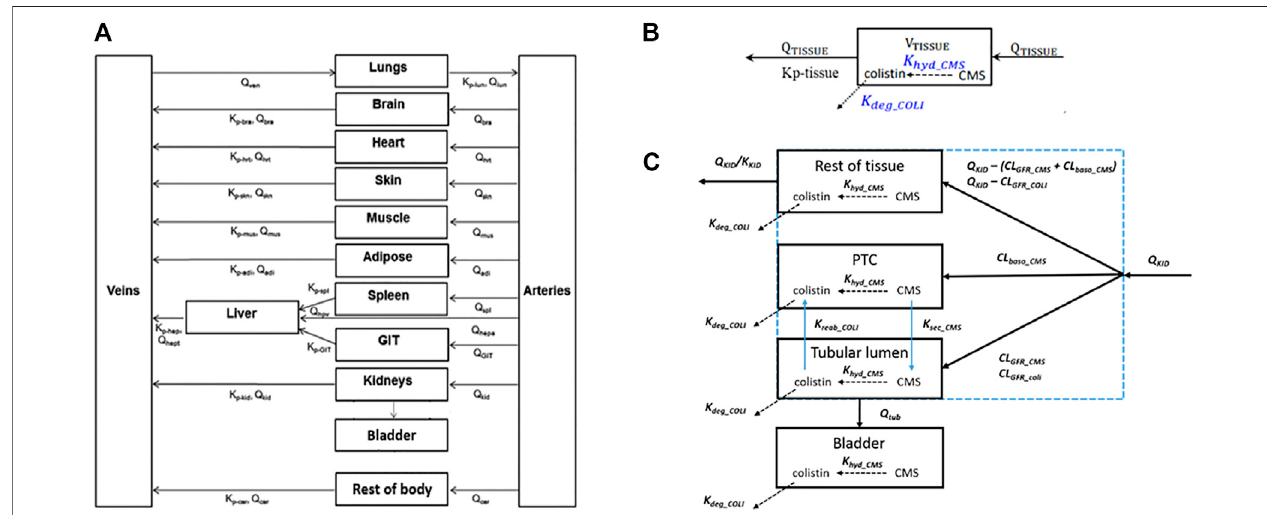
FIGURE2| Schematicrepresentation ofthe model (A) and thedistributionmechanismsofcompounds inthe kidneys (C) ortothe other tissue compartments (B) . Figure (A) was adapted from Bouchene et al. (2018). Figure (B,C) were adapted from Viel et al. (2018). The terms refer to: V TISSUE , tissue volume; Q TISSUE , tissue blood fl ow; Kp-tissue, partition coef fi cient; K fi cient for kidneys; Q fl ow; Q fl uid fl ow; CL KID , partition coef KID , kidney blood TUB , tubular GFR_CMS and CL GFR_COLI , glomerular fi ltration clearanceofCMSandcolistin.CL baso_CMS ,clearanceofCMSfromthebloodtoPTCacrossthebasolateralmembrane ofPTC;K reab_coli ,reabsorptionrate of colistin from the tubular lumen to PTC across the apical membrane of PTC; K sec_CMS , secretion rate of CMS from PTC to the tubular lumen across the apical membrane of